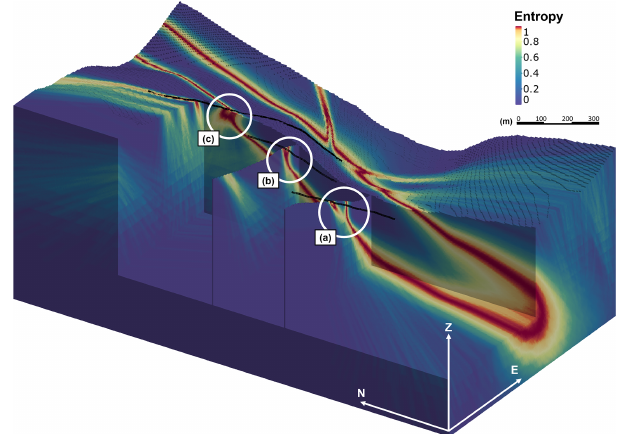
Figure 7. Combined geologic model entropy results for the fault network model, highlighting three intersection points between mi- nor fault zones with the major fault zone: (a) approaching major fault zone boundary, (b) bordering major fault zone boundary and (c) overlapping